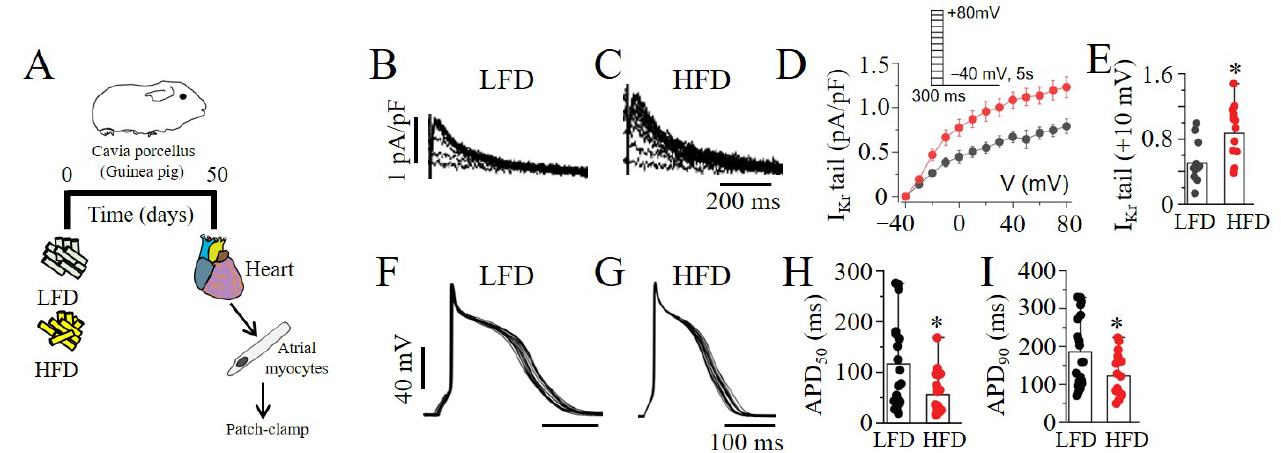
Figure 6. Electrophysiology of I Kr and action potentials in guinea pig atrial cardiomyocytes. ( A ) Experimental protocol: I Kr tail currents and AP were measured in freshly isolated atrial myocytes from adult guinea pig heart under control conditions and after pre-exposure to lipotoxicity for 2 h. Exemplar I Kr tail current traces measured in control cells ( B ) and lipotoxic cells in the absence ( C ) and presence of RAP ( D ). ( E ) Population I–V curves for I Kr tail currents measured in control cells ( black symbol and line ), lipotoxic cells ( red symbol and line ) and in lipotoxic cells pre-treated with RAP ( cyan symbol and line ). ( F ) I Kr tail current amplitude measured at +10 mV under the indicated conditions. Representative AP traces measured in control cells ( G ) and after pre-exposure to lipotoxicity (2 h, H ) and lipotoxicity+RAP ( I ). Statistical analysis of APD 50 ( J ) and APD 90 ( K ) revealed that RAP partially rescued lipotoxicity-induced shortening of APD in atrial myocytes. Data were generated from cardiomyocytes from three guinea pigs. (* statistical significance at p < 0.05).